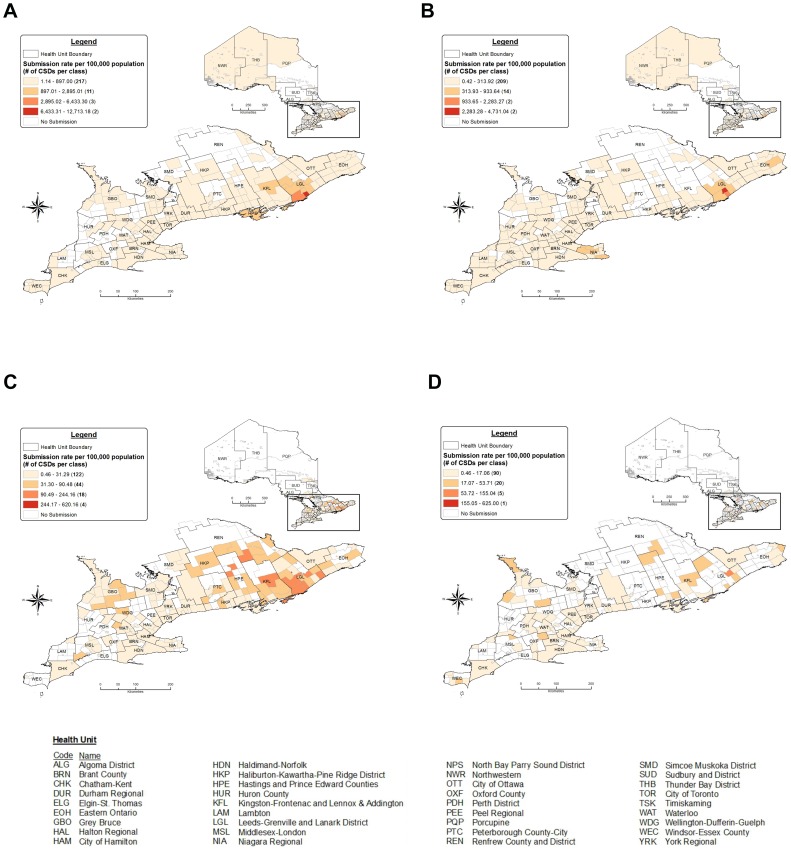
Distribution of ticks submitted for identification in Ontario, Canada (2008–2012) as rates of submission per 100,000 population (based on submitter CSD of residence).A) Ixodes scapularis, B) Dermacentor variabilis, C) Ixodes cookei and D) Amblyomma americanum.† †CSD, census subdivision. All CSDs not visible because of their small size.